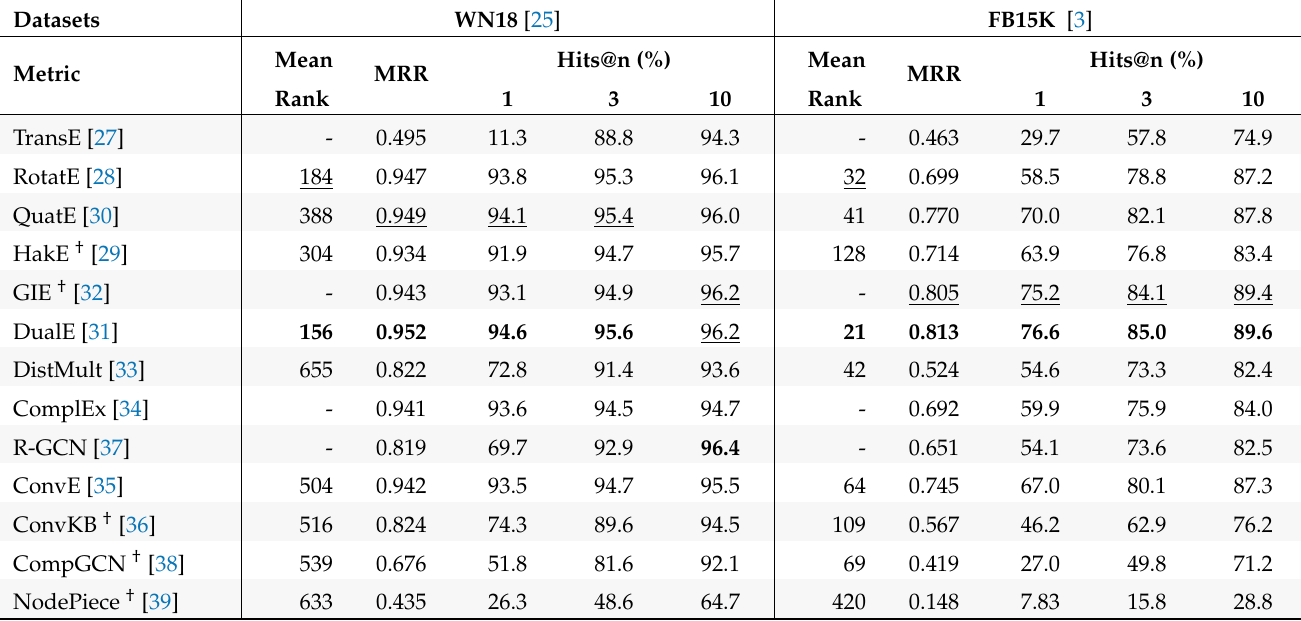
Table 5. Results on the WN18 dataset and FB15K dataset; † refers to ours. Bold and underline denote the best and second best